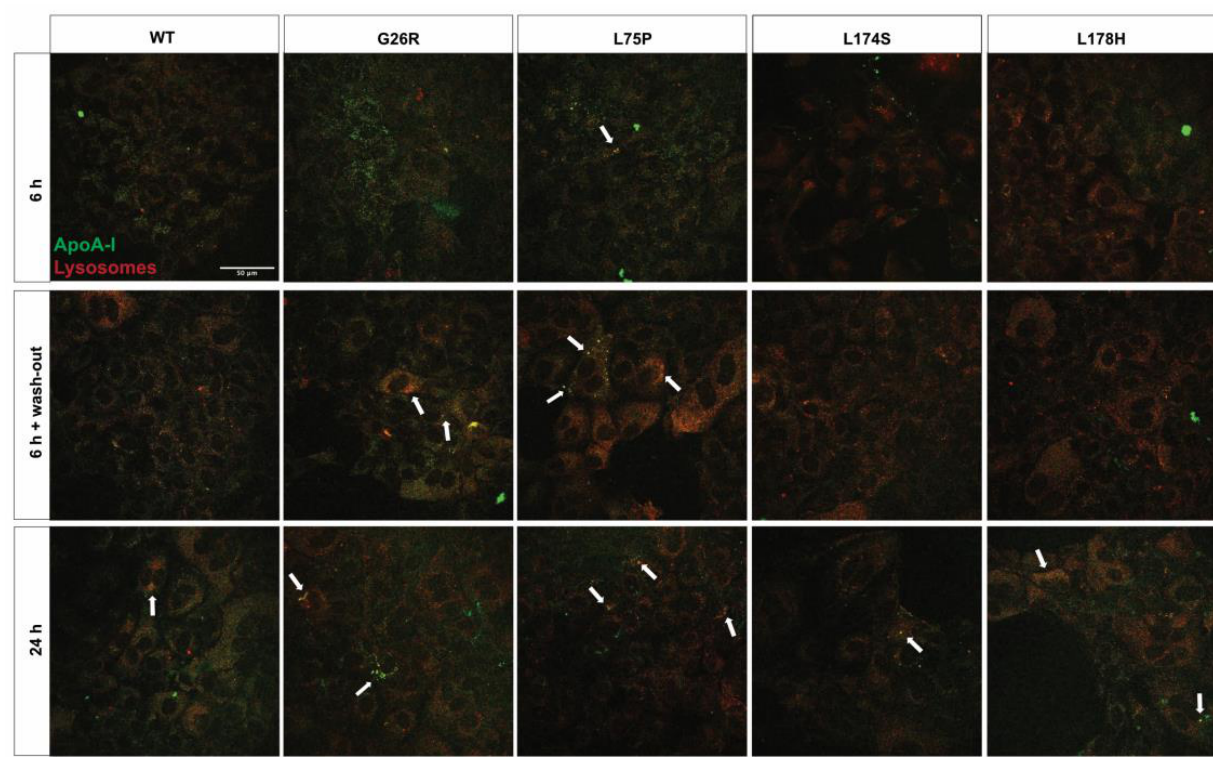
Figure 3. Cellular localization of ApoA-I amyloidogenic variants in NRK-52E kidney cells. NRK-52E cells were incubated with 2 µ M FITC-labelled ApoA-I (green) for 6 h (upper panel), for 6 h followed by incubation in growth medium for additional 16 h to study protein degradation (6 h + wash-out, middle panel), or 24 h (lower panel). Lysosomes were stained with Lysotracker red. Cells were analyzed by confocal microscopy using a 60 × objective. Scale bar is 50 µ m. White arrows indicate protein co-compartmentalization with the lysosomes.